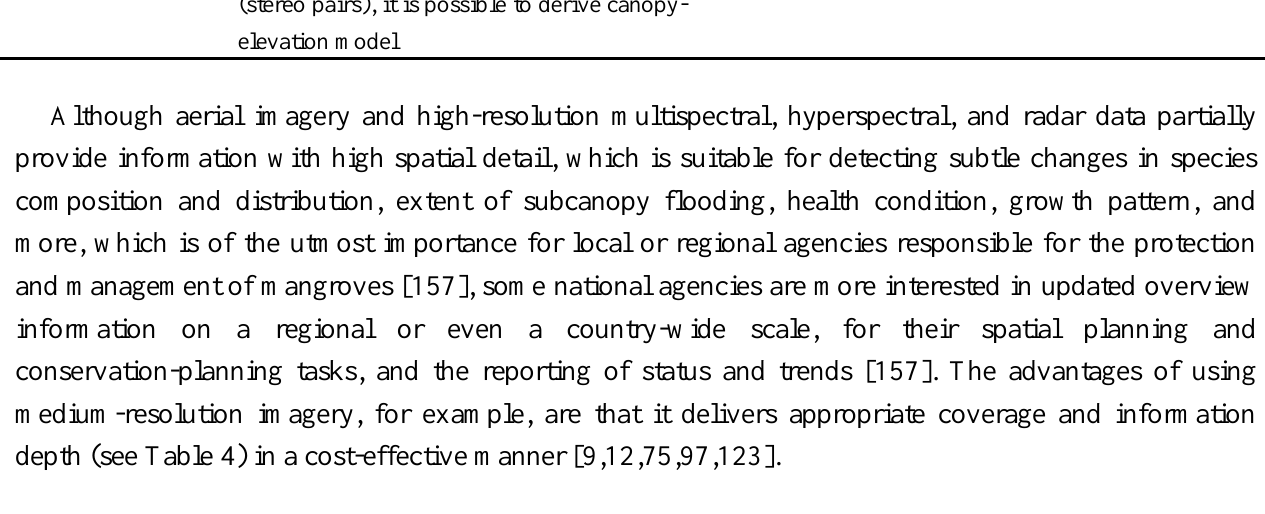
Table 4. Benefits and limitations of medium-resolution imagery for mangrove